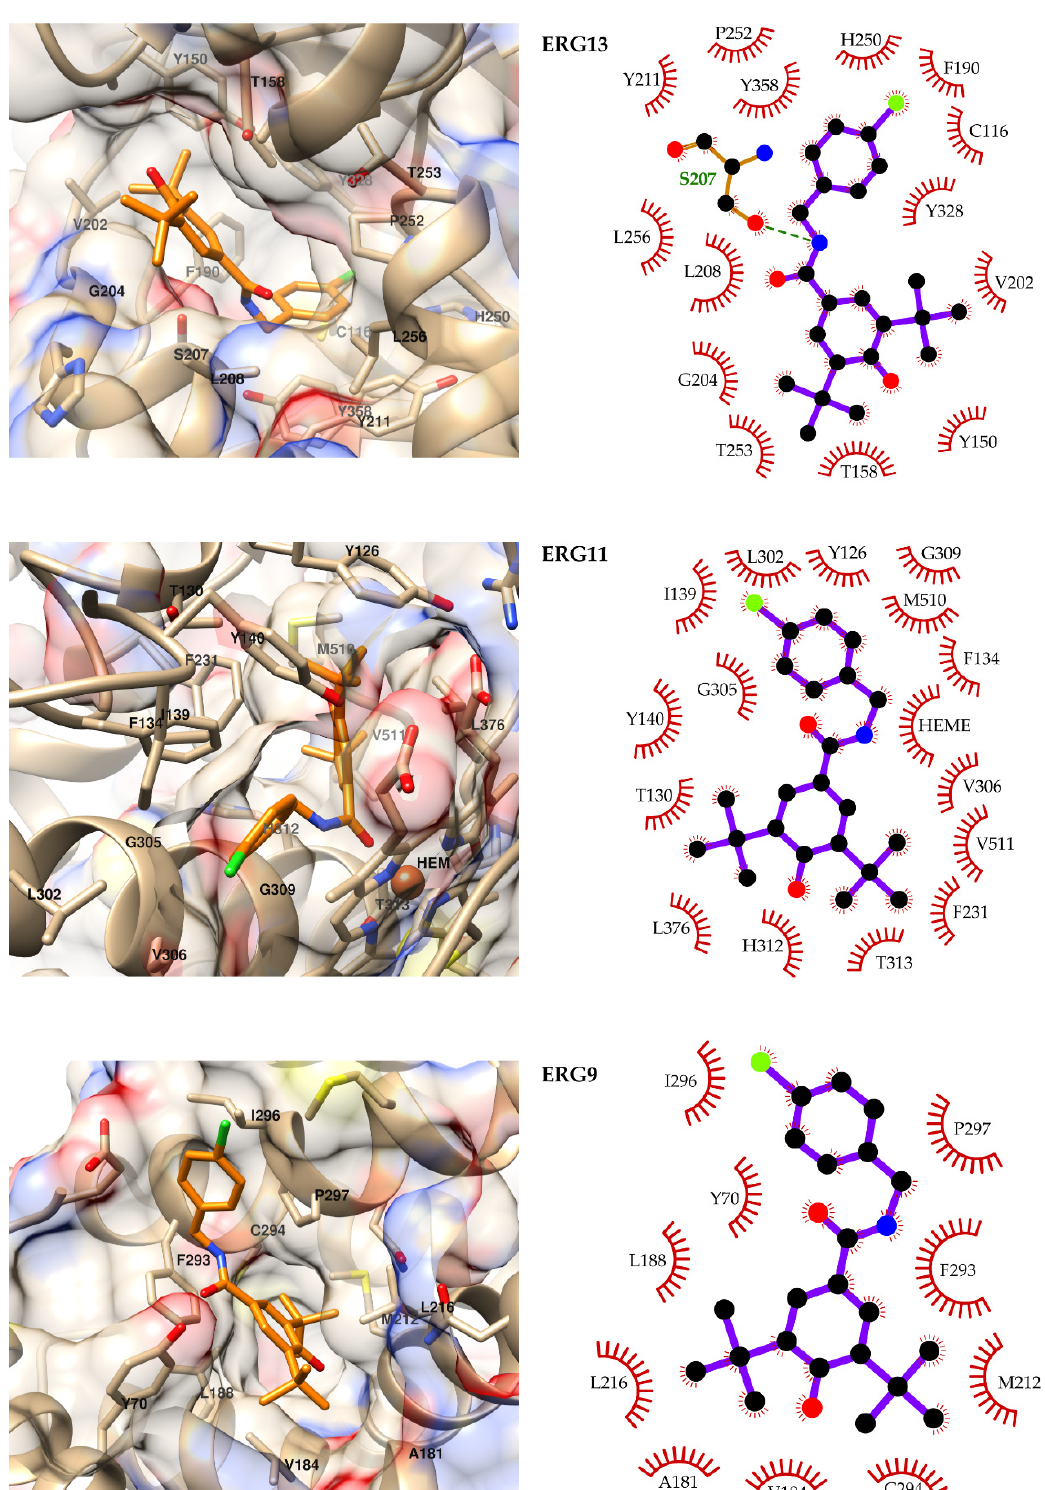
Figure 3. Predicted binding modes of compound 16 to ERG13, ERG11 and ERG9 ( left ) and diagrams of the predicted ligand–receptor interactions ( right ). For representing the predicted binding modes, the ligand is depicted in orange, and the following scheme is used for non-carbon atoms: oxygen is red, nitrogen blue, chlorine green and sulfur yellow. In the interaction diagrams ( left ), carbon atoms are depicted in black, and heavy atoms are represented only for residues forming hydrogen bonds with the ligand.